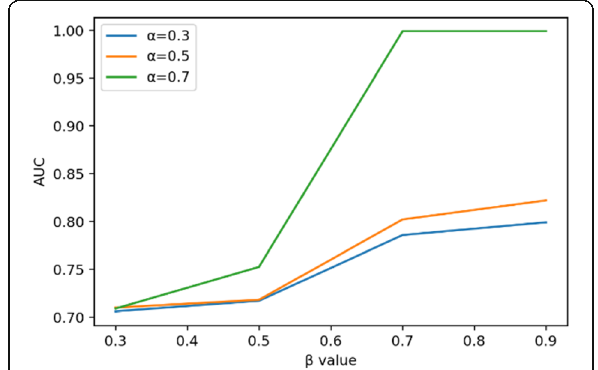
Fig. 8 The different parameters are employed in the function WCN KA to obtain AUC values. α = 0.3, α = 0.5, α =